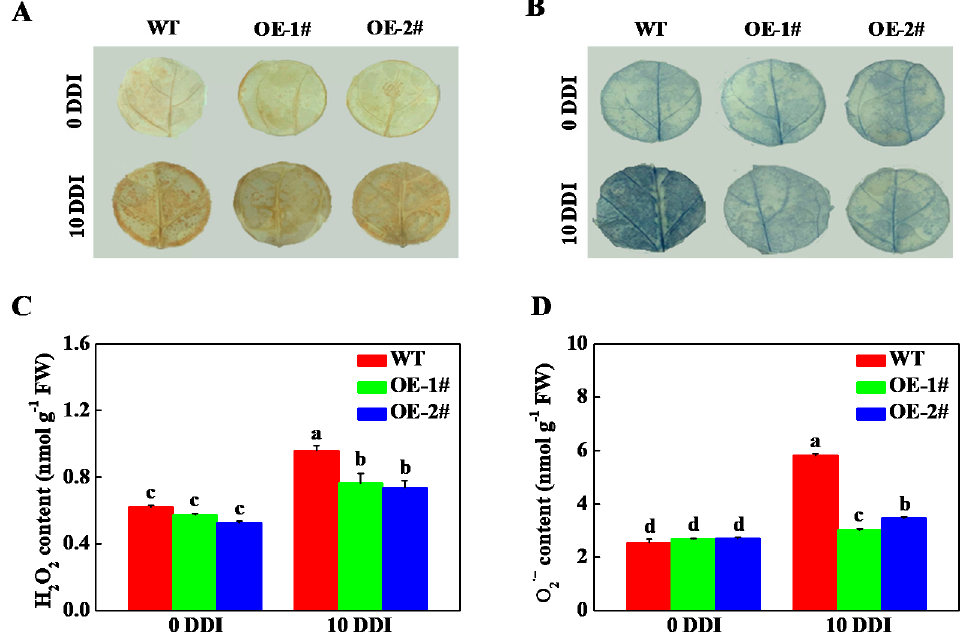
Figure 8. Overexpression of CsHCAR inhibits the accumulation of reactive oxygen species. ( A ) DAB staining; ( B ) NBT staining; ( C ) H 2 O 2 content in leaves; ( D ) O 2 •− content in leaves. The results represent the mean ± SE ( n = 3). Means with the same letter did not significantly differ at p < 0.05 according to Tukey’s test. WT, wild-type; OE-1# and OE-2#, 2 independent transgenic tobacco overexpression of CsHCAR ; DDI, day(s) of dark incubation; FW, fresh weight.